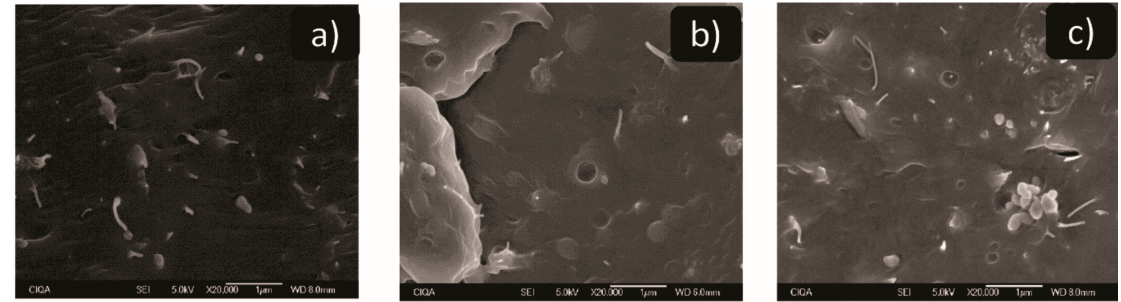
Figure 7. SEM micrographs of nanocomposites. ( a ) polypropylene-carbon-nanotubes (PP-TiO 2 /CNT-1), ( b ) PP-TiO 2 /CNT-5 and ( c ) PP-TiO 2 /CNT-10.